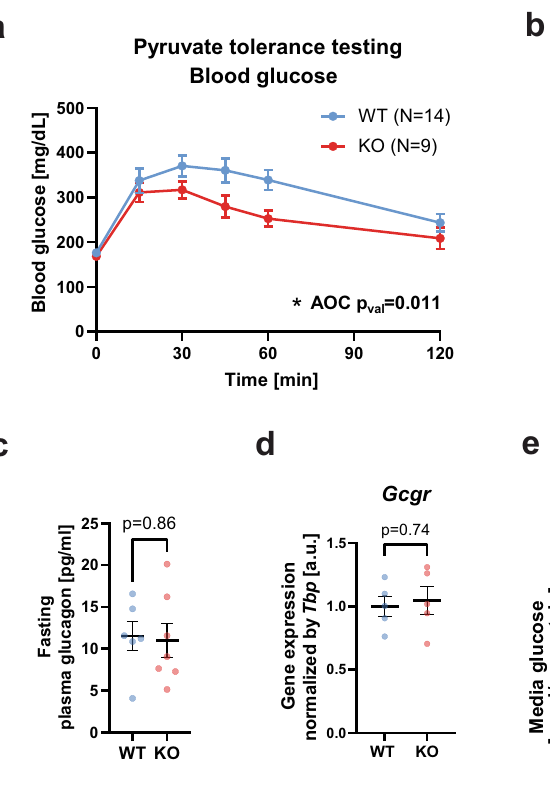
receptor ( Gcgr ) gene expression in the livers from Gpr151 WT and KO DIO male mice. Two-tailed Student ’ s t test ( N =5, WT; N =5, KO). e Quanti fi cation of media glucose produced by Gpr151 WT and KO primary hepatocytes ex vivo, normalized by protein concentration. Results of one experiment representative for